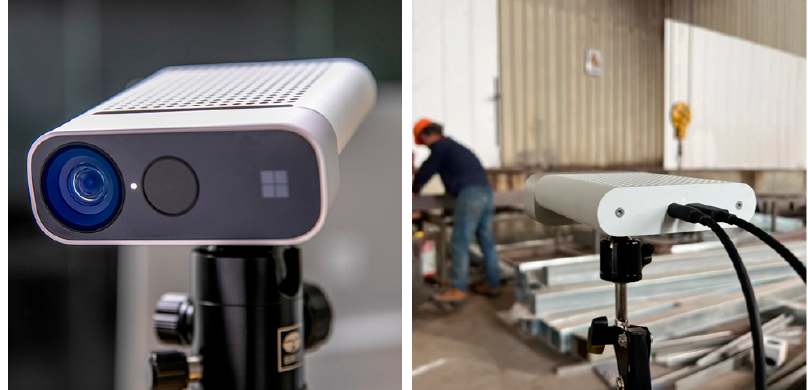
Figure 7. Microsoft Azure Kinect for data collection in a steel modular construction factory.